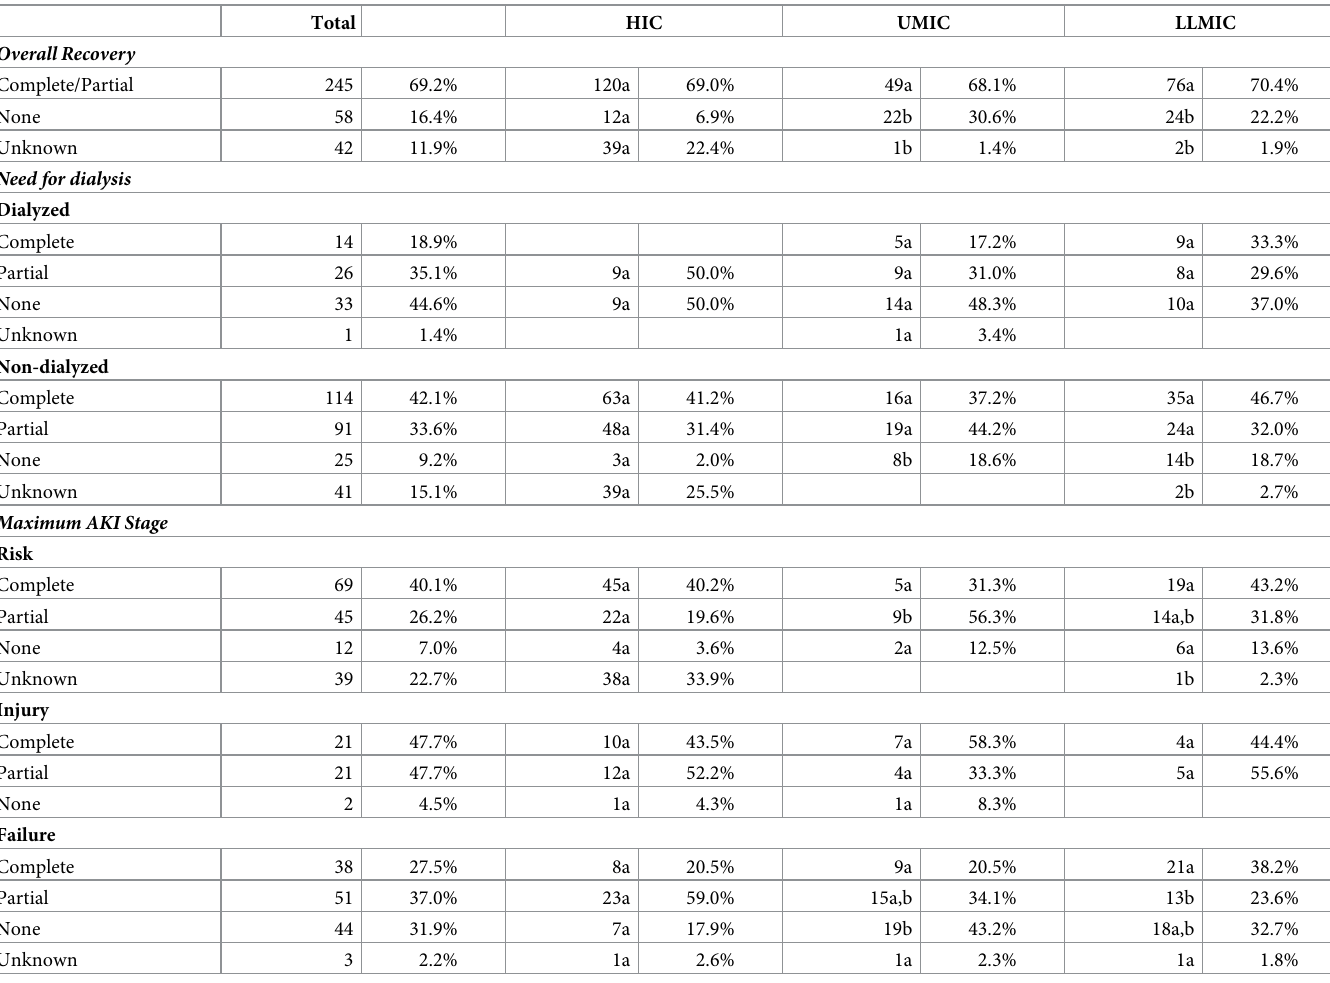
Table 4. Recovery status at seven days in patients receiving and not receiving renal replacement therapy by GNI